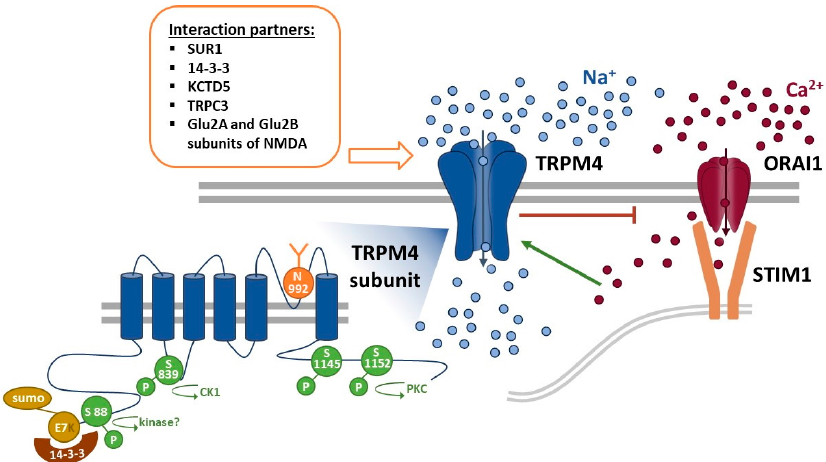
Figure 1. Activation of TRPM4 and the regulation of Ca 2+ entry. An increase in intracellular Ca 2+ concentration activates TRPM4, which opens and conducts a large influx of Na + ions. The positively charged Na + ions then depolarize the plasma membrane and thereby inhibit store-operated Ca 2+ entry (SOCE) via the Orai1 channel. The dysregulation of intracellular Ca 2+ signaling is linked to several cancer hallmark functions, including increased proliferation, migration, invasion, and the inability to induce apoptosis. TRPM4 has several interaction partners that, in part, have been shown to modulate its functions, including SUR1 [102], 14-3-3 [102], KCTD5 [39], SUMO [16], TRPC3 [102], and subunits Glu2A and Glu2B, which are subunits of the NMDA receptor [100]. In addition, TRPM4 can be glycosylated and phosphorylated.